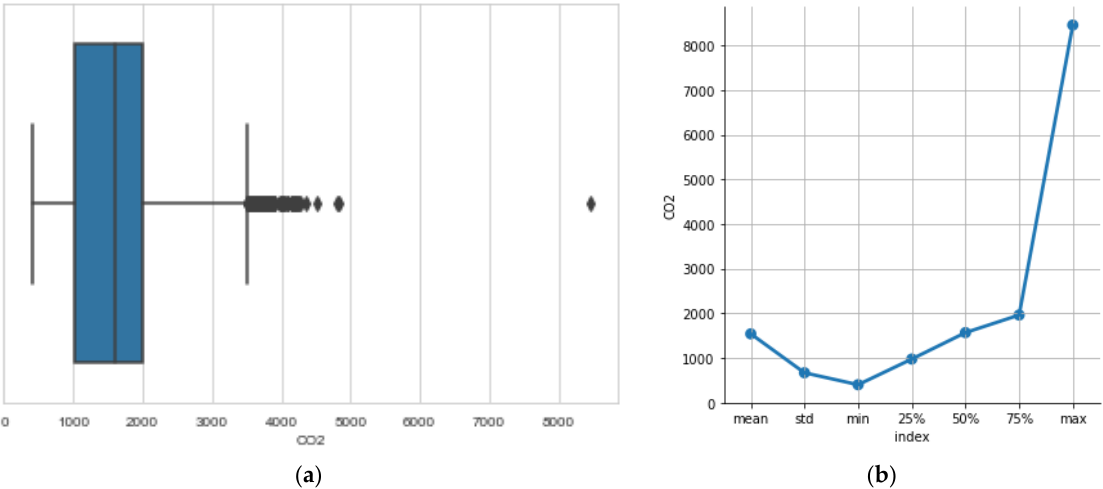
Figure 7. ( a ): boxplots pinpoint outliers in the recordings of CO 2 concentration. They also show most probable value of concentration and the spread of values. ( b ): descriptive statistics: the mean value, the spread denoted by std (standard deviation), the min and max values are of special importance to the interpretation of the data.